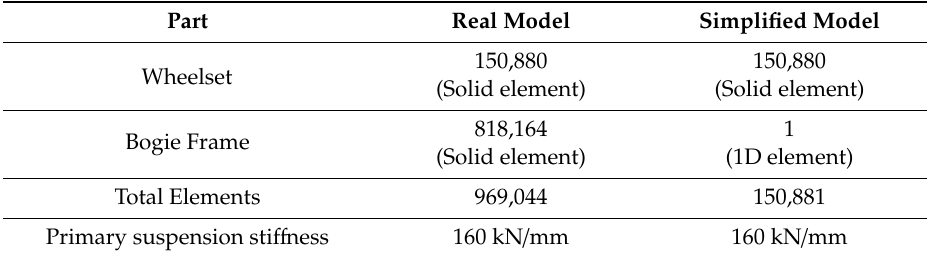
Table 2. The comparison of elements of the 3-piece